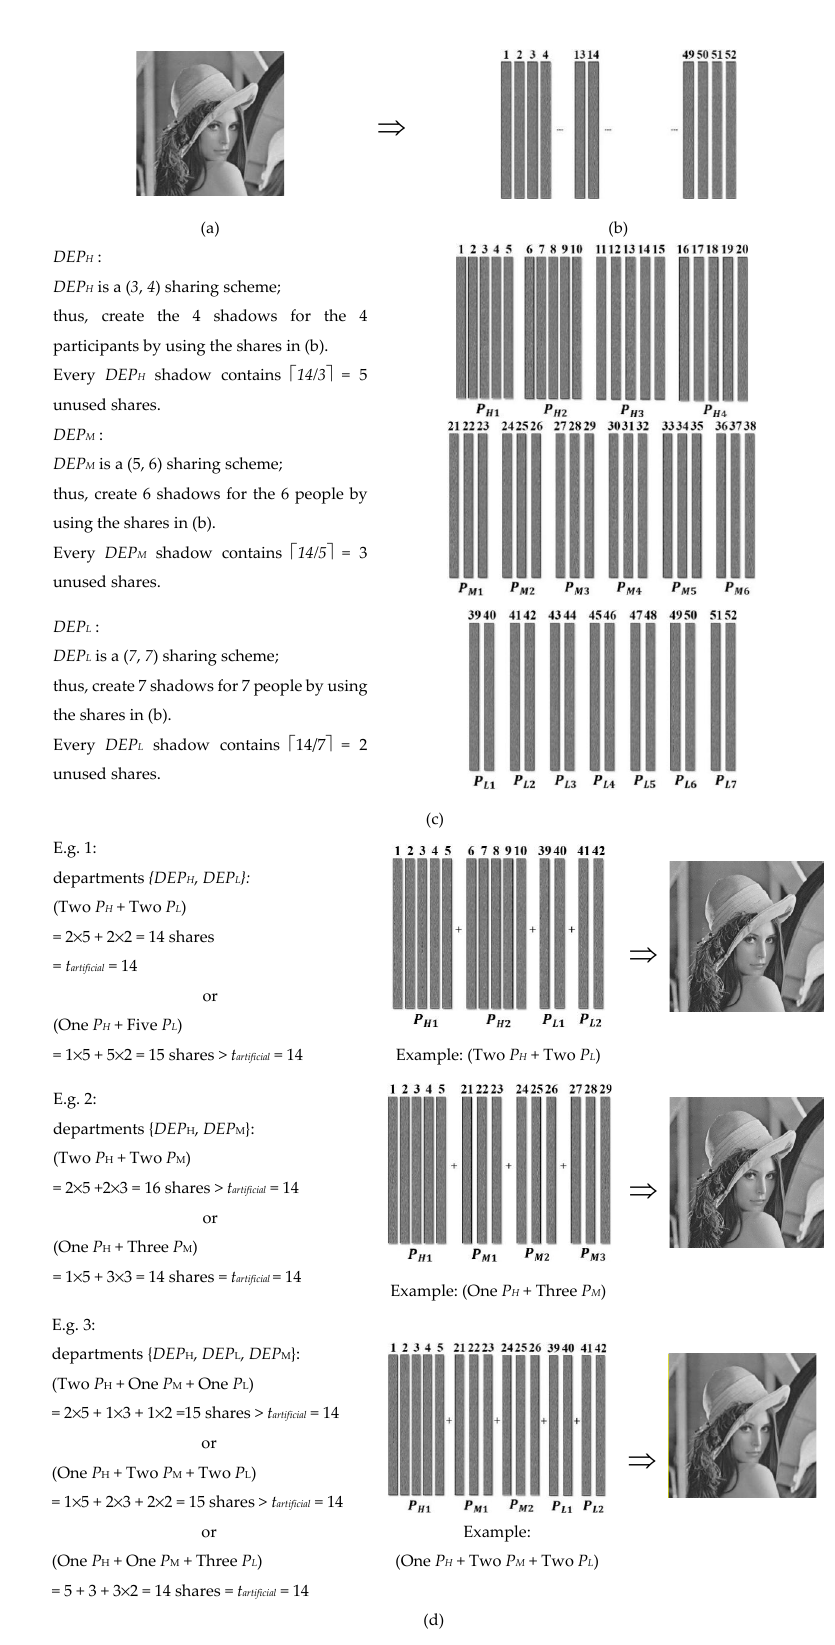
Figure 2. Sharing and decryption experiment for the cross-department support system. (a) is original image; (b) uses (14, 52) sharing to create 52 shares; (c) creates shadows for the 3 departments; (d) shows three examples of the secret image being unveiled under a cross-department support system.